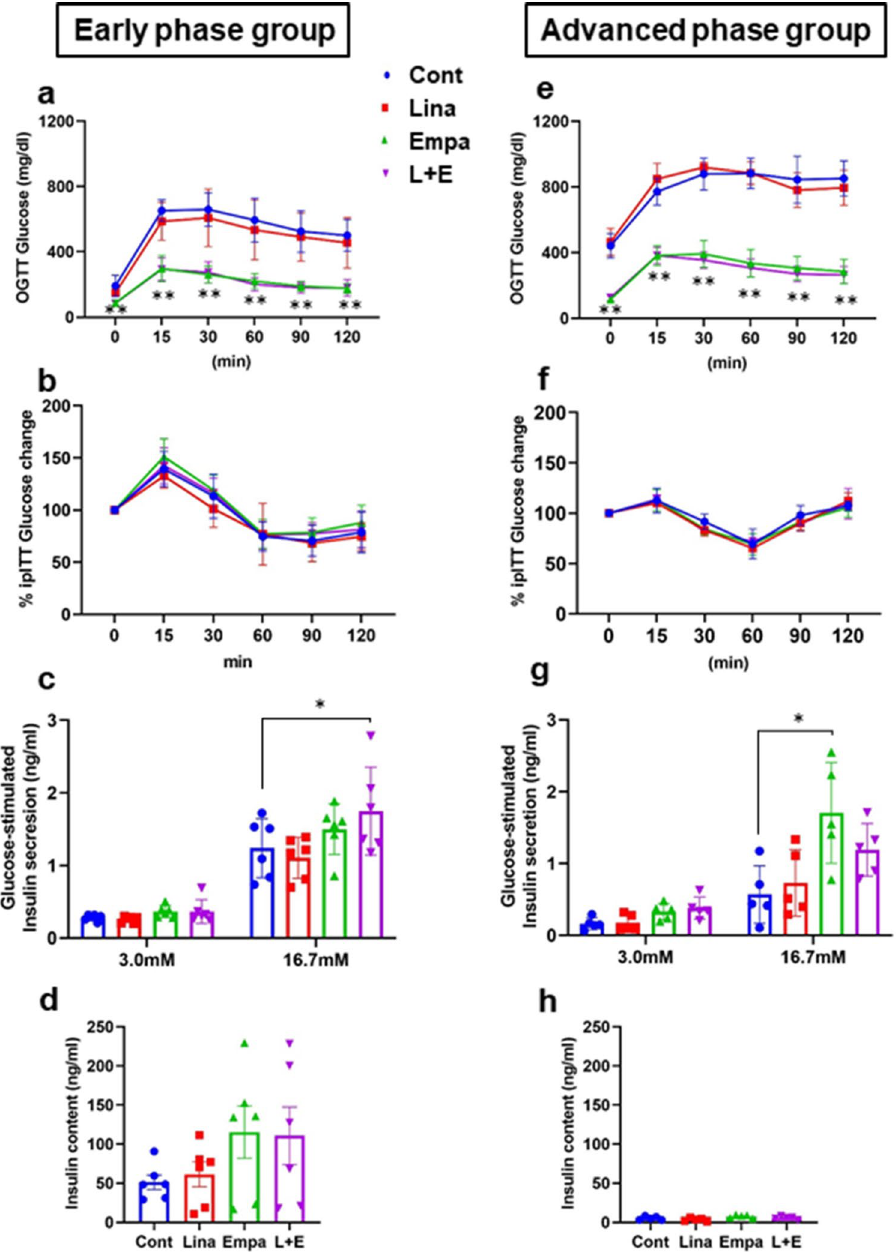
Figure 2. ( a , b ) Blood glucose levels after oral glucose tolerance test in an early and advanced phase of diabetes. ( b , f ) Blood glucose levels after insulin tolerance test in an early and advanced phase. ( c , g ) Glucose-stimulated insulin secretion (GSIS) was accessed after exposure to low (3.0 mmol/l) and high (16.7 mmol/l) glucose concentrations. ( d , h ) Insulin contents in pancreatic islets after GSIS. ( a , b , e , f ) n = 8, ( c , d ) n = 6, ( g , h ) n = 5. The multiple comparison was performed using the Tukey–Kramer method. Data are presented as mean ± S.D. *: p < 0.05, **: p <